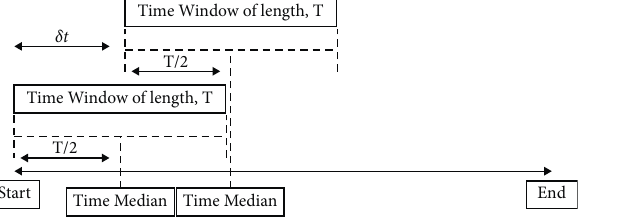
Figure 7: Here, we show how we take a rolling window for a long time series (from the start to the end). We highlight two fixed time windows, of certain length, T, with time median that corresponds to the middle of these windows. This time window then shifts in time, by δ t , taken here to be six months.